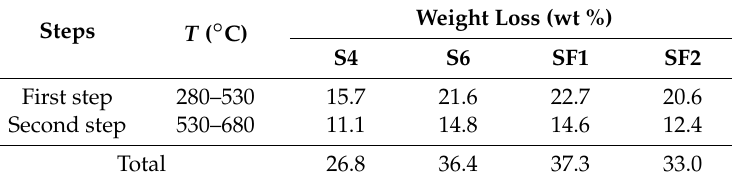
Table 4. Coating weight losses (%).